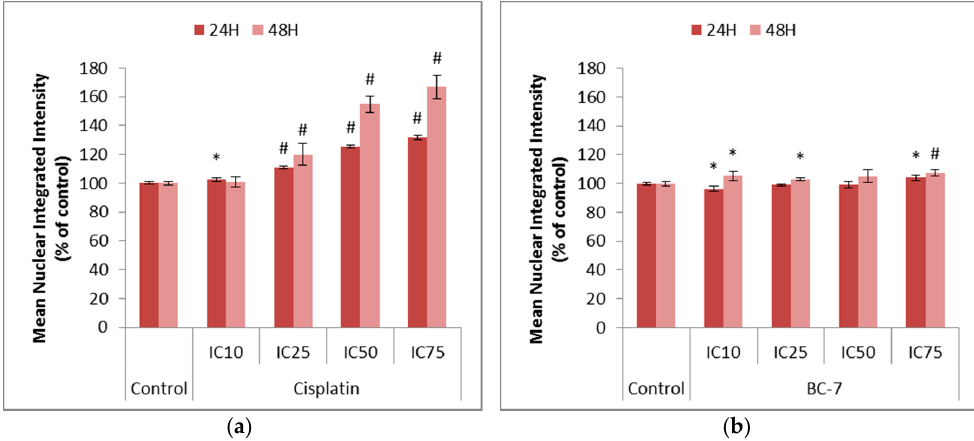
Figure 5. Nuclear Factor kappa B (NF- κ B) analysis in HeLa cells after 24 and 48 h of treatment with ( a ) cisplatin and ( b ) BC-7. Immunofluorescence staining with phospho-p65 NF- κ B was done. Control treatment refers to untreated control. Results displayed as a mean nuclear integrated intensity and expressed as a percentage of the untreated control. Error bars indicate SD of three individual